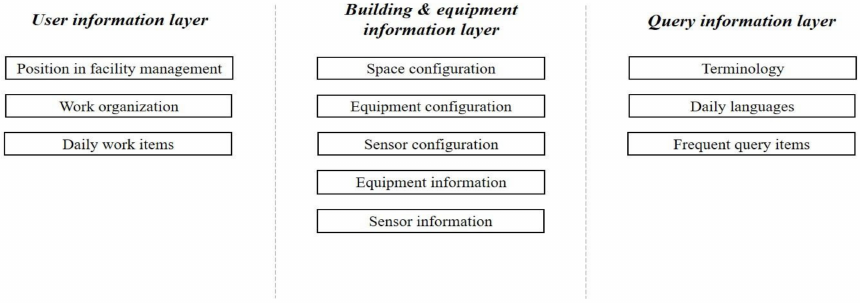
Figure 3. Structure of the equipment dataset.